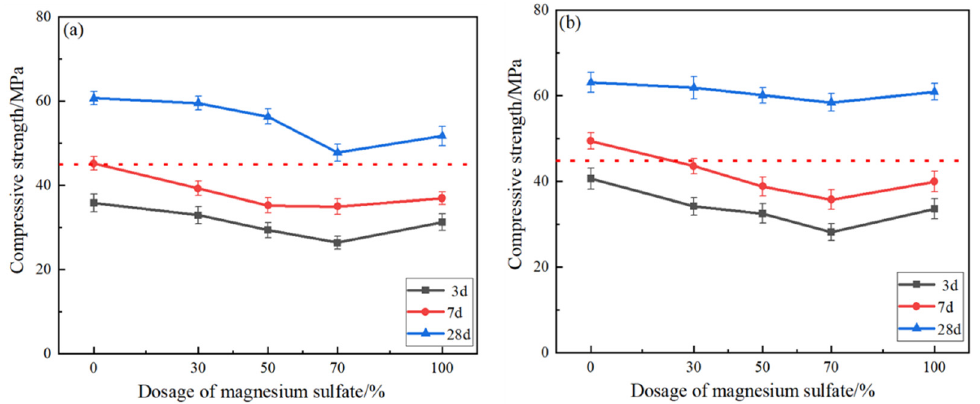
Figure 2. The compressive strength of MOC with different mass fractions of MgSO 4 at air curing ( a ): 6:1:15; ( b ): 7:1:18.